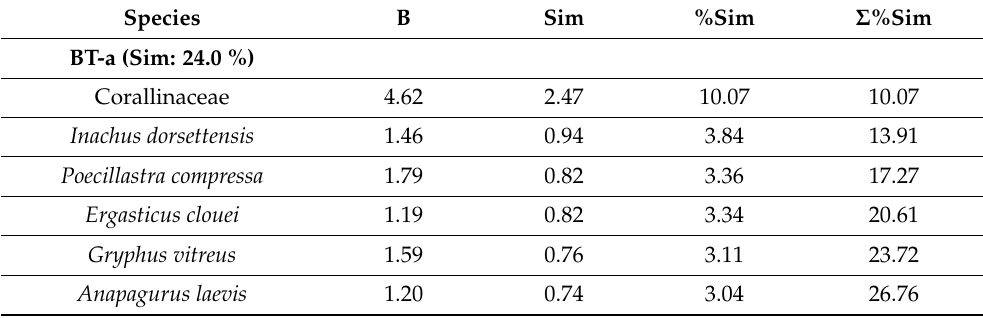
Table A8. SIMPER results of the assemblages (see codes in Figure 7) identified from multi-variant analysis of samples obtained with beam trawl, rock dredge, and experimental bottom trawl in the Ses Olives, Ausias March, and Emile Baudot seamounts and adjacent area of the Mallorca Channel (Balearic Islands, western Mediterranean), showing the average standardized biomass (B: g/500m 2 ), abundance (A: individuals/km 2 ) and occurrence (Occurr), the similarity (Sim), and the percentage contribution to the similarity (%Sim) of the main species or taxa contributing up to 90% of within- group similarity. Both abundance and biomass values were square root